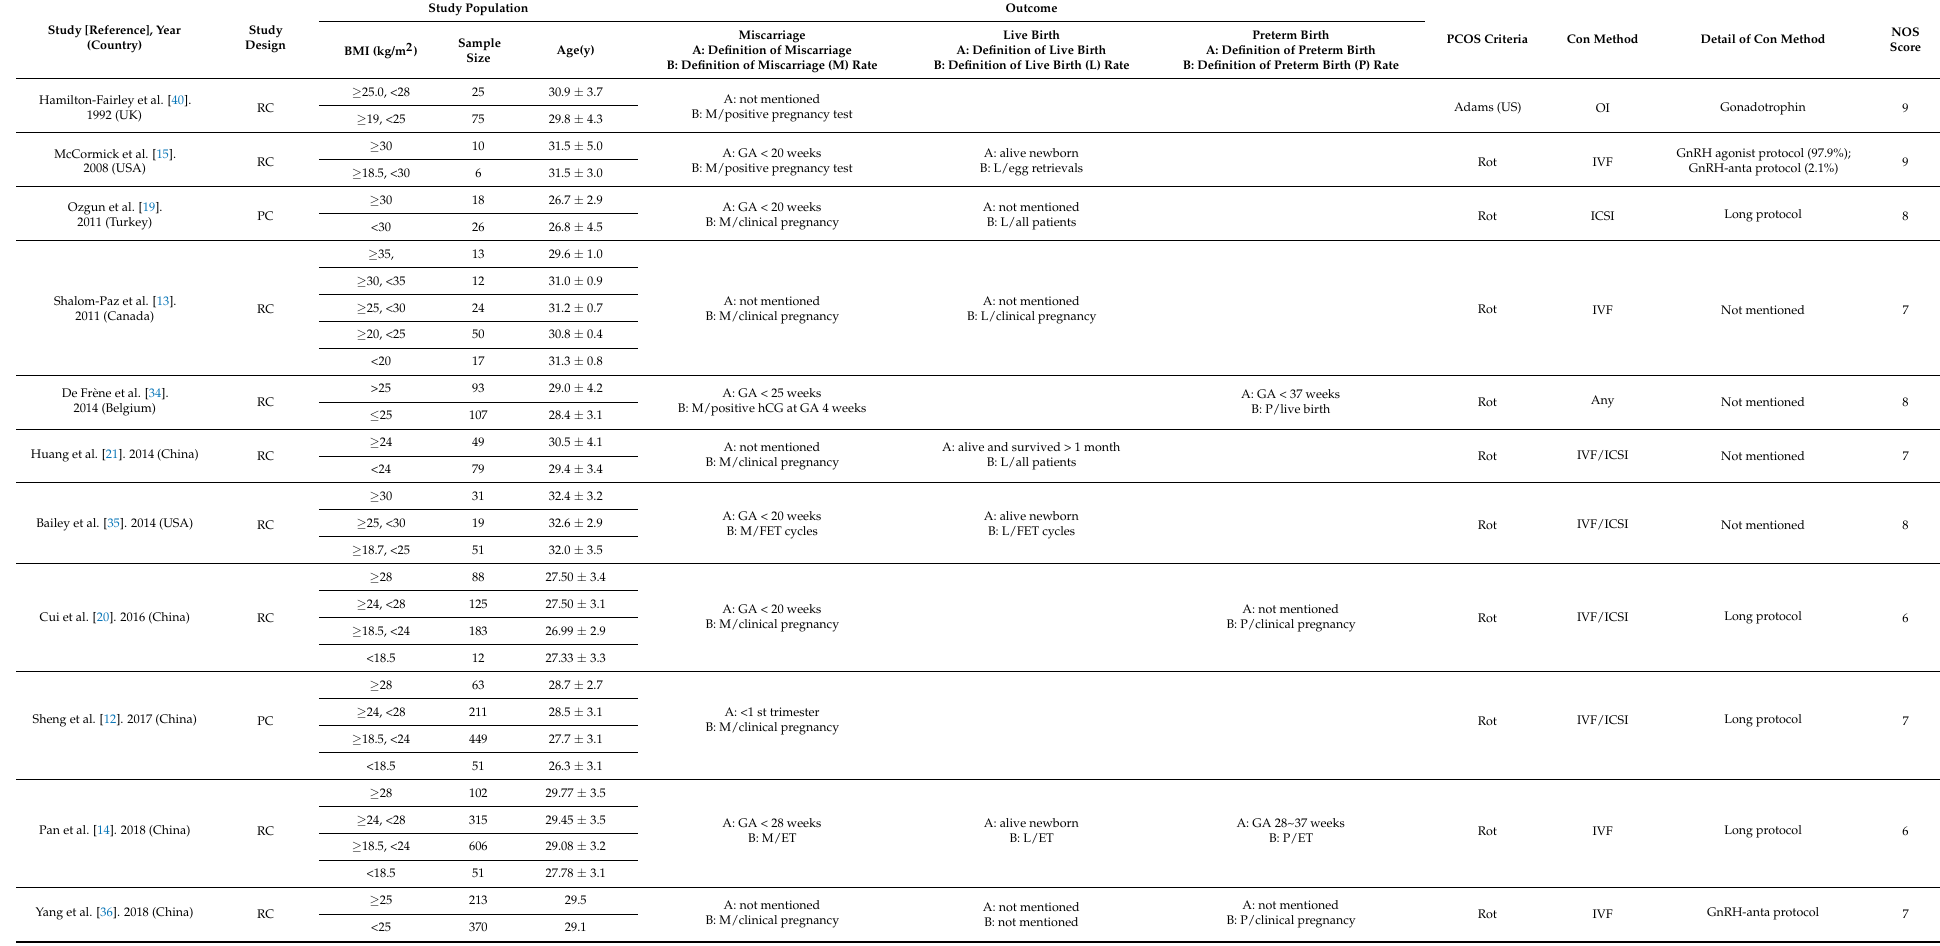
Table 1. Characteristics of the included